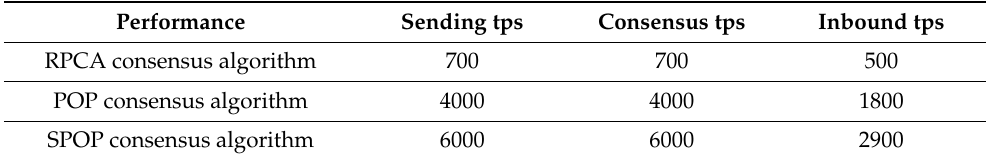
Table 4. SPOP Consensus Performance Test